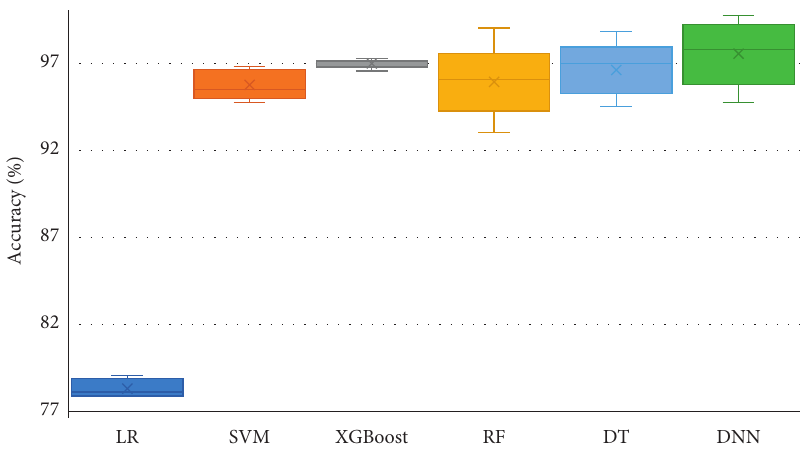
Figure 9: Performance comparison of classifiers based on accuracy.